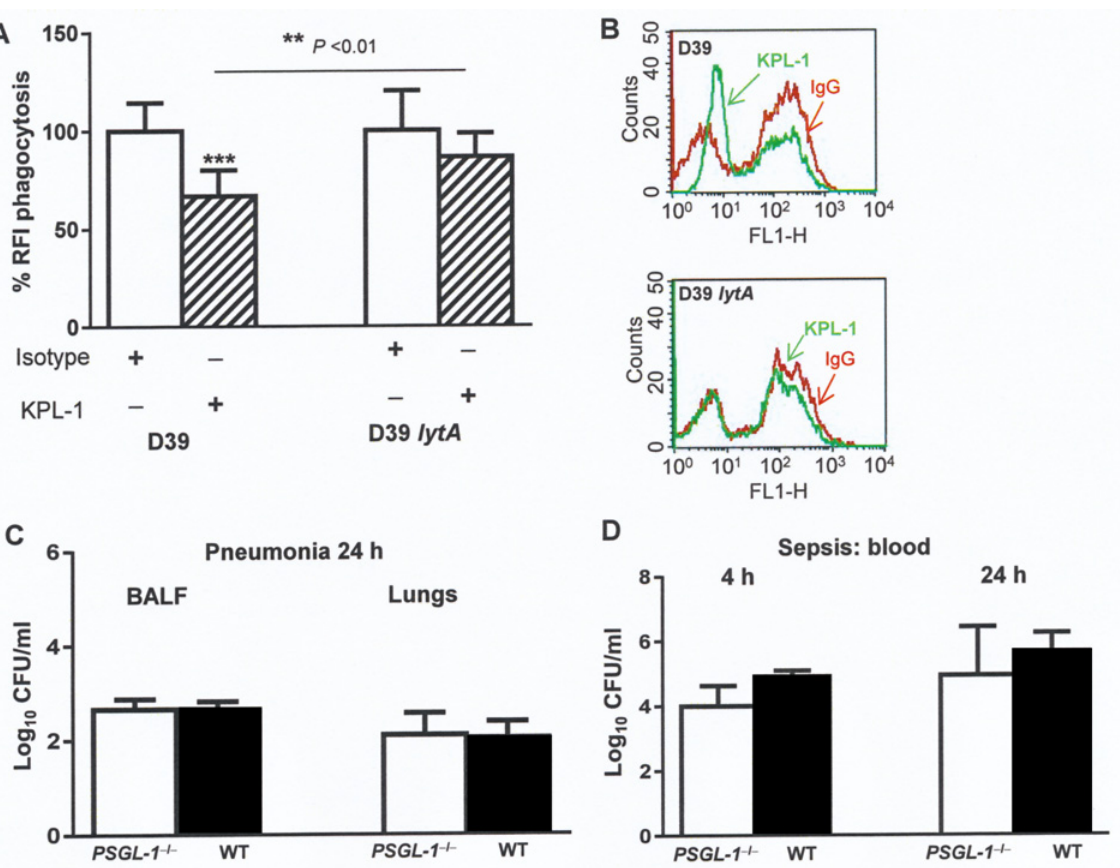
Fig 8. Lack of LytA counteracts PSGL-1 deficiency. (A) Phagocytosis of FAM-SE-labeled pneumococcal strains (D39, D39 lytA ) using HL-60 cells exposed to IgG isotype control (open bar) or exposed to KPL-1 (striped bar). (B) Example of flow cytometry histograms showing phagocytosis by HL-60 cells exposed to IgG isotype control (red) or KPL-1 (green). Error bars represent the SDs and asterisks indicate statistical significance after incubation with KPL-1 compared to the exposure to IgG isotype control. ** P < 0.01 for the comparison between D39 vs D39 lytA in HL-60 cells exposed to KPL-1. (C) Bacterial levels recovered at 24 h from BALF and lungs of PSGL-1 − / − or wild-type mice after pneumonia infection with the pneumococcal D39 lytA mutant. (D). Bacterial levels recovered at 4 h and 24 h from blood of PSGL-1 − / − or wild-type mice after intraperitoneal infection with the pneumococcal D39 lytA